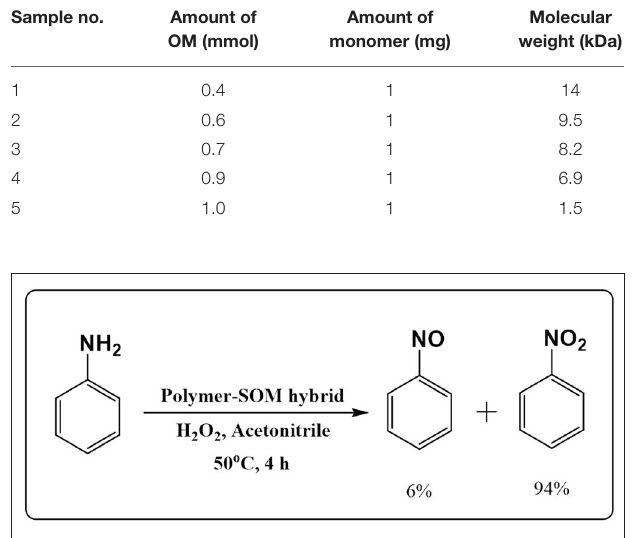
FIGURE 9 | Schematic of aniline oxidation by SOM-polymer hybrid in acetonitrile.